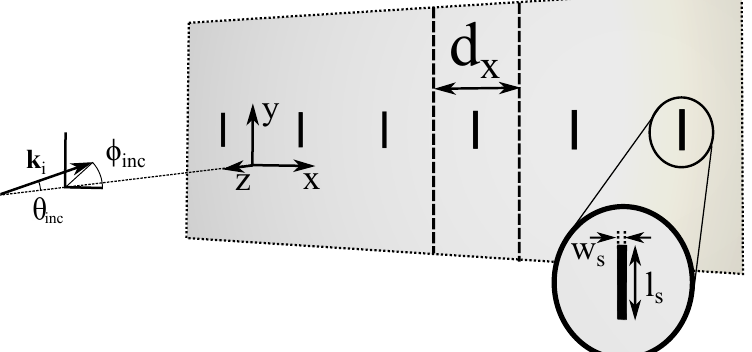
Figure 1. Perspective view of a chain of slot apertures cut into an infinite perfectly conducting screen of negligible